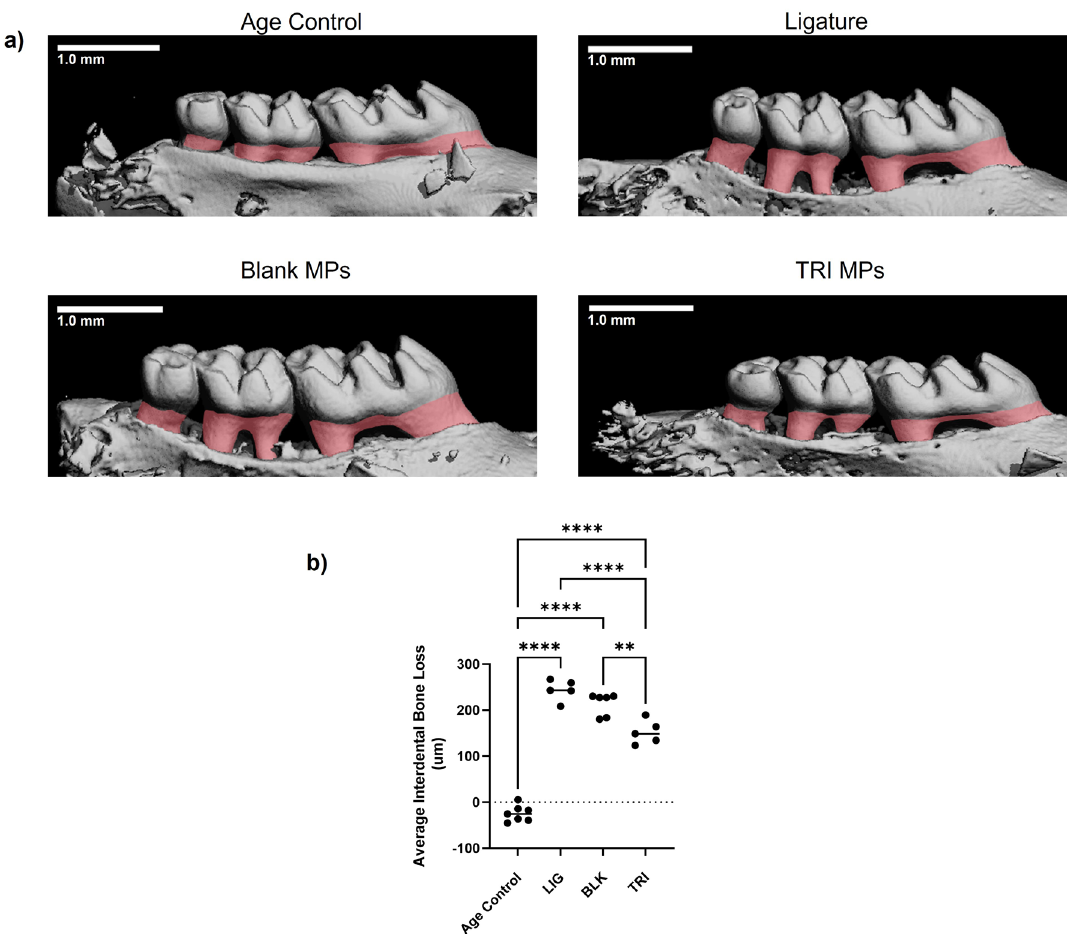
Figure 2. TRI MPs reduce ligature-induced alveolar bone resorption. An injection of MPs was administered to male Balb/c mice (6–8 weeks old) at the same time as ligature placement around the maxillary second molar. After 7 days, bone loss was assessed by micro-CT. ( a ) Representative 3D reconstructed micro-CT scans of the age control, ligature (diseased untreated), blank MPs (PLGA vehicle-only control) and TRI MPs experimental groups (scale bar = 1 mm). ( b ) Average bone loss quantified by linear interdental measurements between the cementoenamel junction and alveolar bone crest (CEJ-ABC) of the ligated maxillary second molar for each experimental group (n = 5–7 mice). A One-way ANOVA was performed followed by Tukey post-hoc analysis to compare the mean of every group with the mean of every other group to determine statistical significance where; ** p ≤ 0.01, *** p ≤ 0.001, **** p ≤ MPs, approximately 5.5 ng were released before the profile reaches a plateau as compared to IL2 MPs with a burst release of approximately 28 ng before plateauing. Rapamycin MPs have a steadier, more linear release pro- file, reaching approximately 3500 ng by day 7 (Fig. 1b). Lastly, surface morphology was detected with scanning electron microscopy (SEM). As demonstrated in the representative SEM images, TGFβ MPs with the addition of poly (ethylene glycol) (PEG)-PLGA di-block copolymer, are spherical with an uneven or bumpy surface. Rapamycin MPs have a smooth and spherical appearance. IL2 MPs have a porous surface morphology (Fig. 1c). TRI MPs reduce alveolar bone resorption in an aggressive periodontitis model. Next, local treatment with TRI MPs was evaluated in regard to the impact on alveolar bone loss in an aggressive, ligature- induced periodontitis model. Interdental bone loss was assessed for age control, diseased untreated (ligature only), vehicle control (ligature + blank MPs) and treated (ligature + TRI MPs) groups. Representative 3D recon- structed images reveal a visual difference (overlayed in red) in the bone level between the groups (Fig. 2a). Blinded analysis of the interdental measurements show our TRI MPs successfully reduced interdental alveolar bone loss by approximately ~ 30–40% when compared to the ligature only group and ~ 10–20% when compared to the vehicle control (Fig. 2b). Additionally, the age control group represents a baseline of very minimal natural bone loss with values near zero (or negative) from normalizing the left interdental measurements to the right side, internally. This is further validated with Masson–Goldner trichrome immunohistochemical staining. Lines of demarcation highlight the anatomical limits of the area where the focus is on the alveolar bone, gingiva and periodontal ligament. Arrows (Fig. 4a) point to areas of high bone loss for the ligature only and blank MPs group while arrows highlight areas of bone preservation in the age control and TRI MP group. The boxed region of the